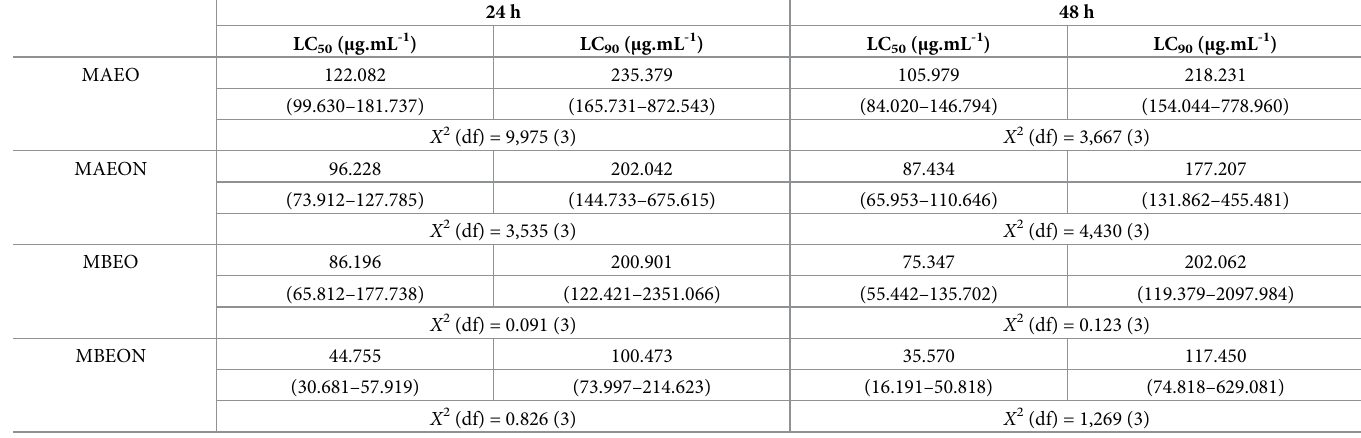
microscopy. Results indicated deformation of anal papillae, and changes deriving from peeling epithelial tissue in the region located in the of the larvae abdomen, as shown in Fig 4. Essential oils are highly selective for octopaminergic receptors that are distributed in neural and non-neural tissues [54]. Studies have shown that essential oils can modify the activity of Table 5. Lethal concentration in order to kills 50% and 90% of 3 rd instar larvae of A . aegypti in contact with the essential oils or the nano-emulsions of A . triplinervis morphotypes, and their lower and upper